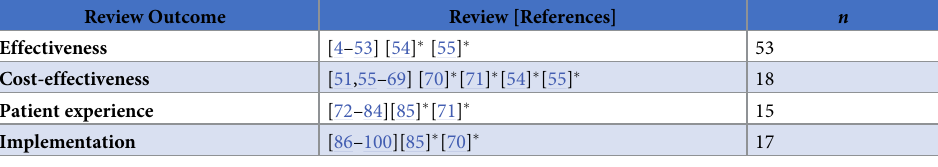
Table 1. Classification of telemedicine reviews according to review